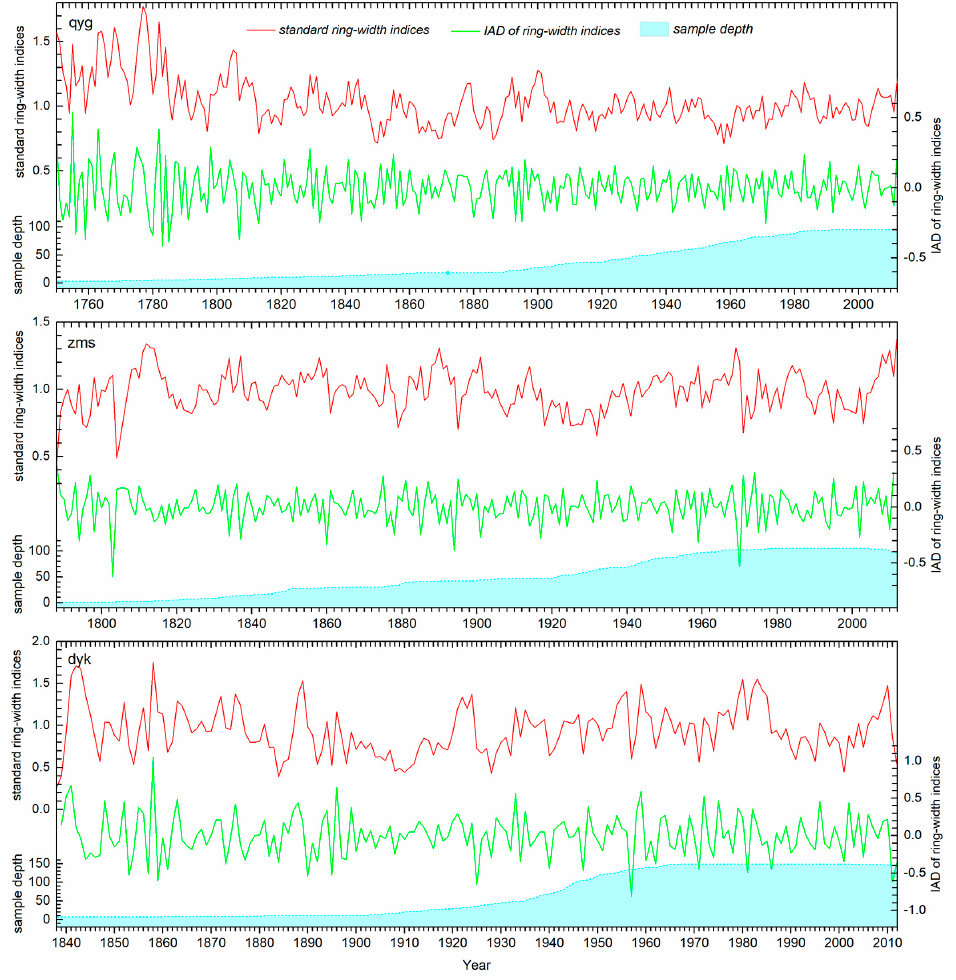
Figure 2. Standard tree-ring width chronologies and inter-annual difference (IAD) of ring-width indices for Qinghai spruce from the three sample sites.